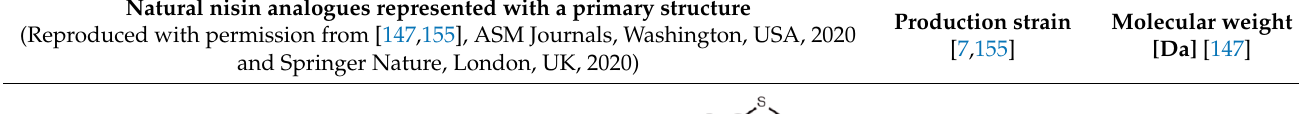
Table 3. Primary structures of nisin natural analogues. The changes in amino acids compared to nisin A are highlighted in yellow (not valid for Nisin J).